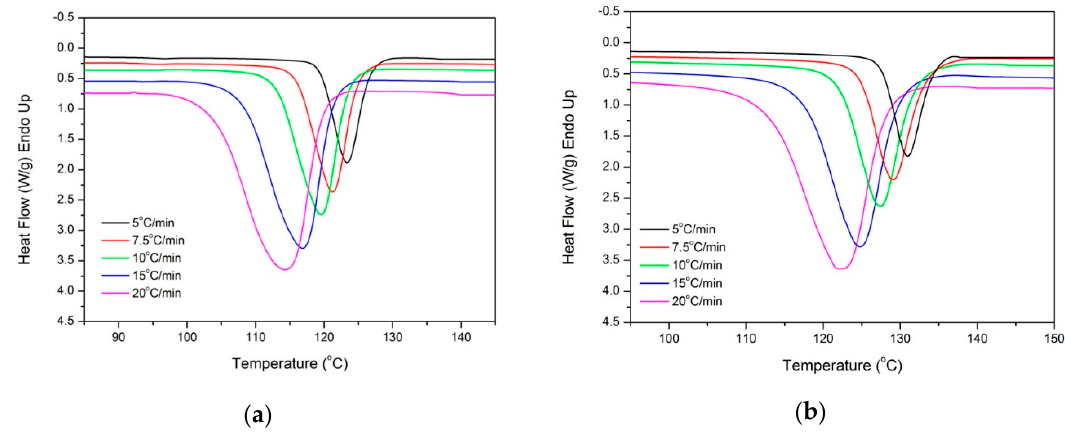
Figure 7. Di ff erential scanning calorimeter (DSC) non-isothermal crystallization exothermic peaks recorded at di ff erent cooling rates for ( a ) PP and ( b ) PP–GNP10